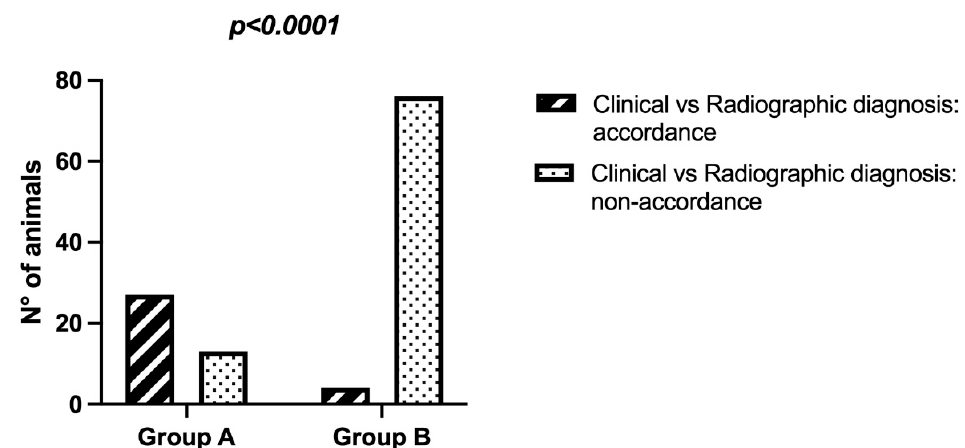
Figure 1. Chi-squared test between groups A and B, considering the accordance or non-accordance between clinical and radiographic diagnosis.